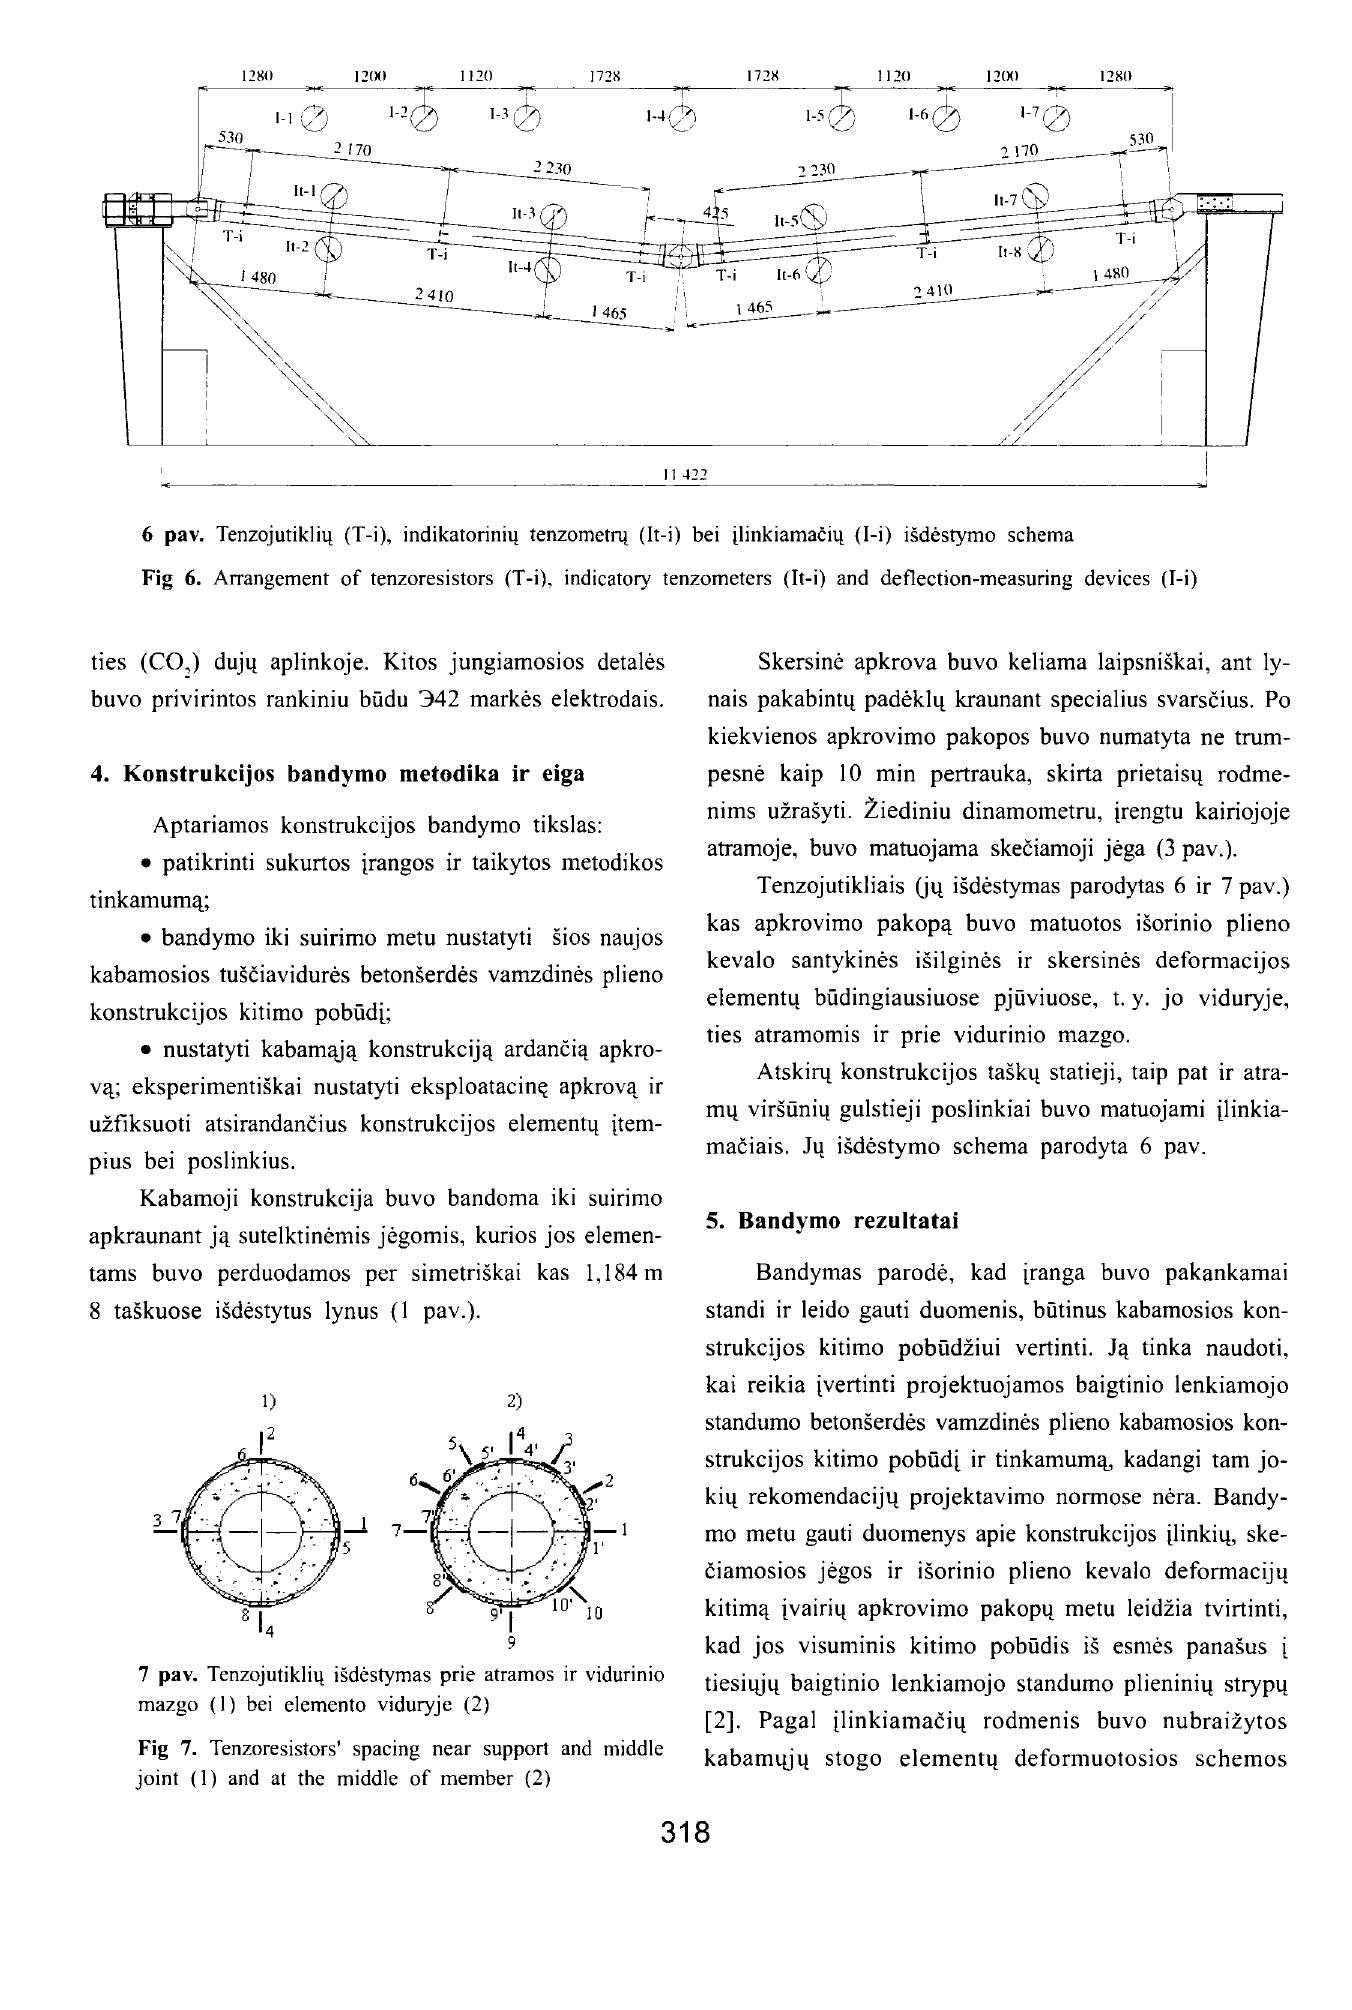
Fig 7. Tenzoresistors' spacing near support and middle joint (I) and at the middle of member